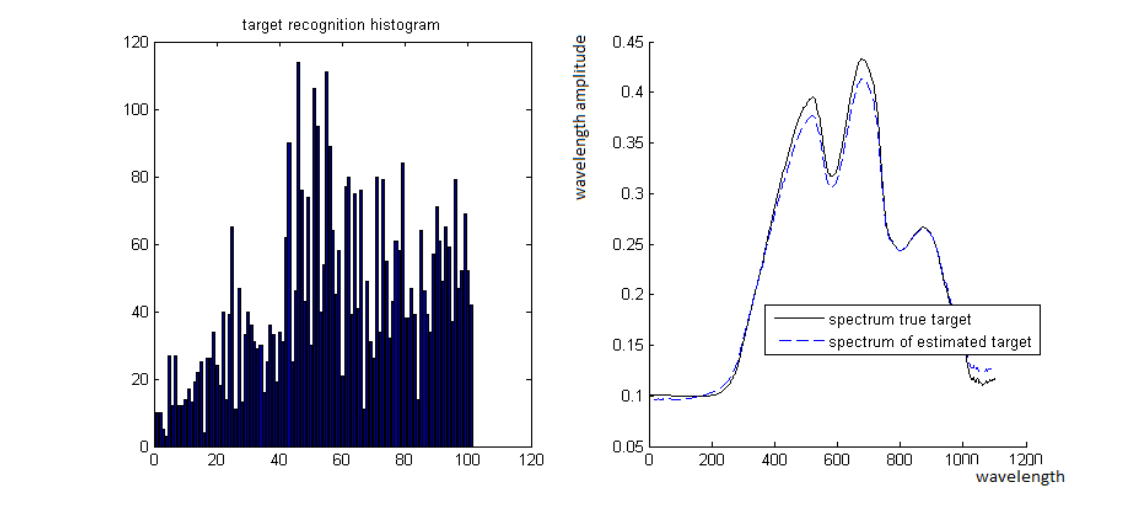
Figure 14. Left: The “unmixing histogram” from Definition 5.1. Right: Comparison between B and its estimation ˆ B